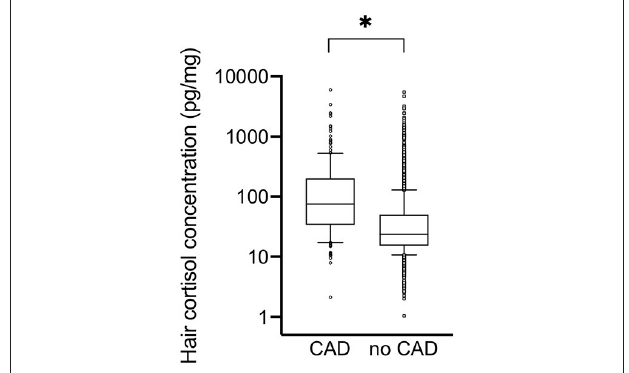
FIGURE 2 | Hair cortisol concentration among participants with or without coronary artery disease (CAD). The hair cortisol concentration given on a logarithmic scale. The line represents the median, box 25th to 75th percentile, and whiskers 10th to 90th percentile. * p < 0.0001 for difference between the groups.